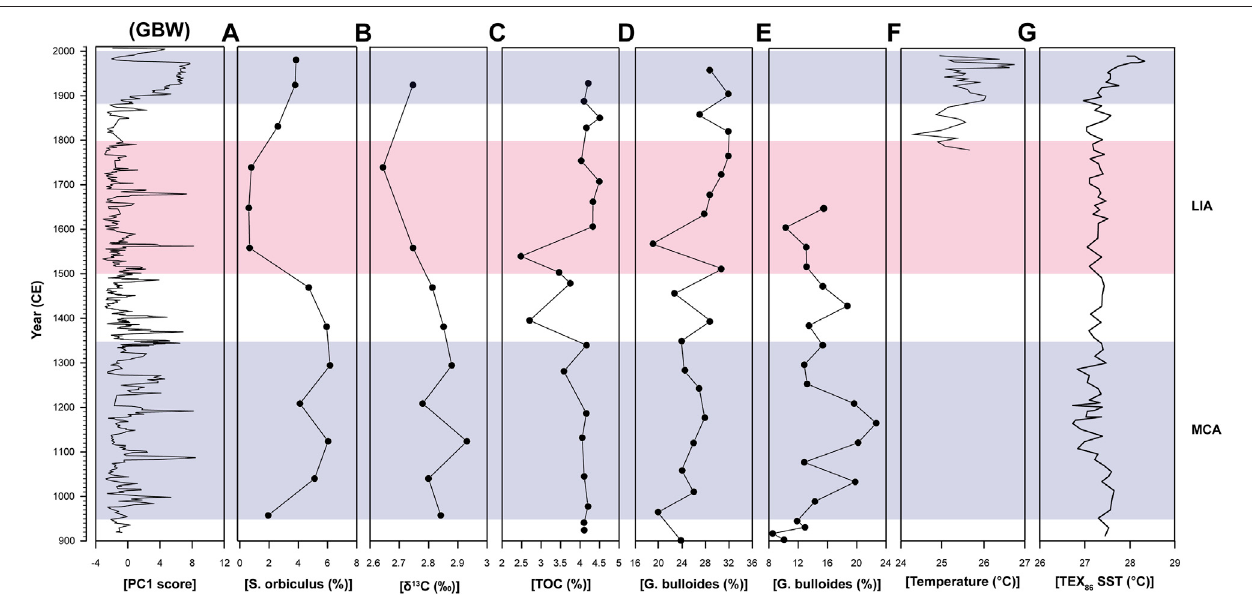
FIGURE10| ComparisonoftheGBWrecordwithotherregionalpaleoclimaticdata. (A) δ 13 Cand (B) TOC,bothfromShuaibaLagoon(SaudiArabia;Abu-Ziedand Bantan,2015), (C) TOCvaluesfromNaroMoruTarn(MountKenya;Fastooketal.,1999), (D) G.BulloidesfromcoreRC2735(Andersonetal.,2010)and (E) G.Bulloides from coreODPHole723A(Guptaet al.,2003),both fromtheArabian Sea(Oman margin). (F) TEX86temperature reconstructionfrom LakeTurkana(Berke etal.,2012). (G) δ D wax data for the past millennium from a Gulf of Aden core (Tierney et al., 2015).